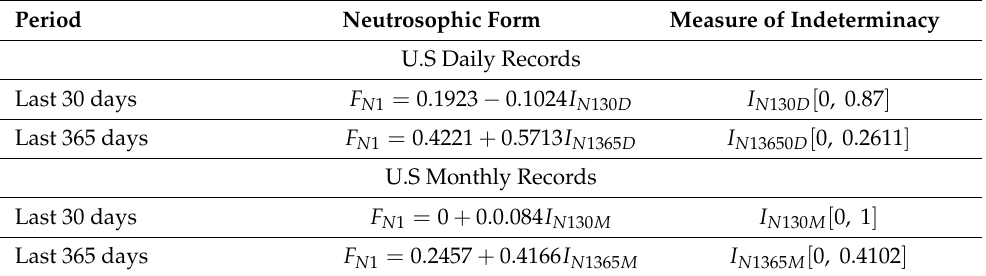
Table 3. Neutrosophic analysis of F N 1 (cid:101) [ F L 1 , F U 1 ] two datasets.